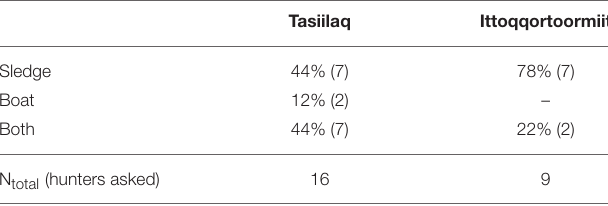
TABLE 3 | Distribution of responses to question 26: “What is the means of transport you use nowadays when hunting polar